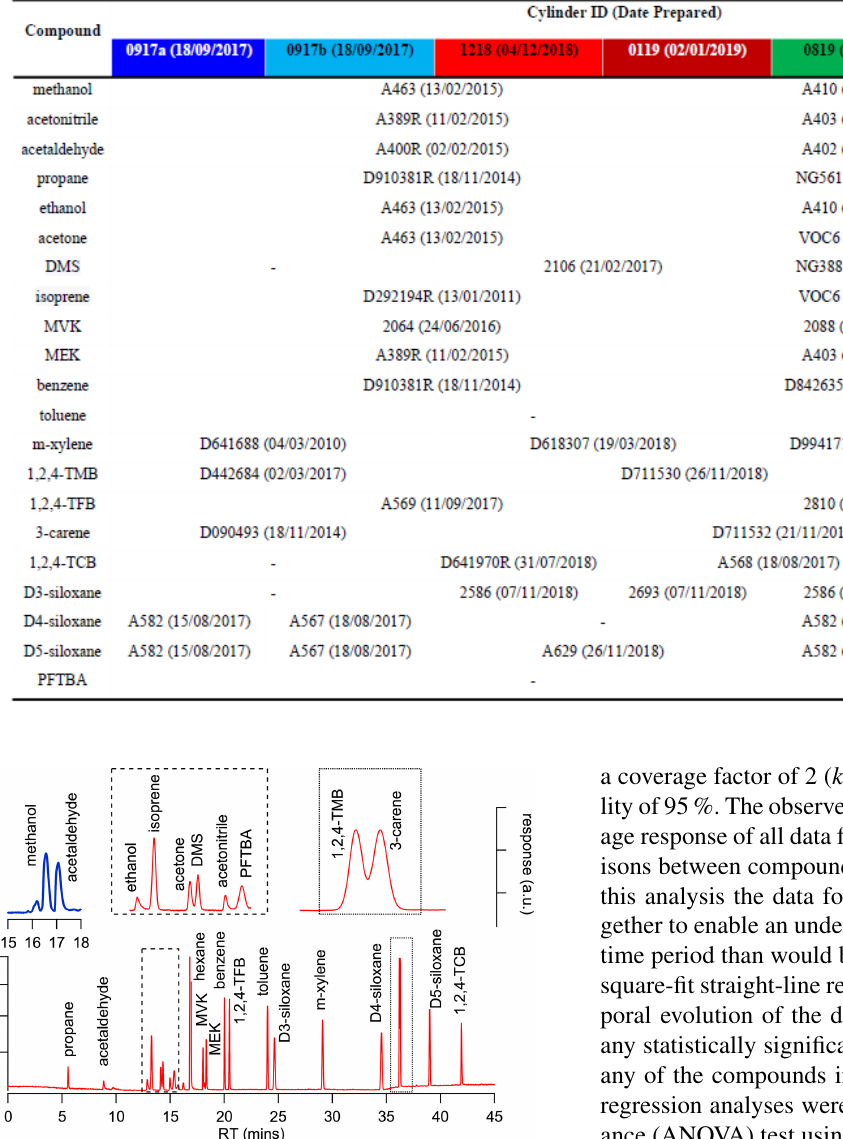
Figure 1. Chromatogram of PRM 0819 showing separation of com- pounds in the GC-FID/MS (red trace) and Cryo-GC-FID (blue